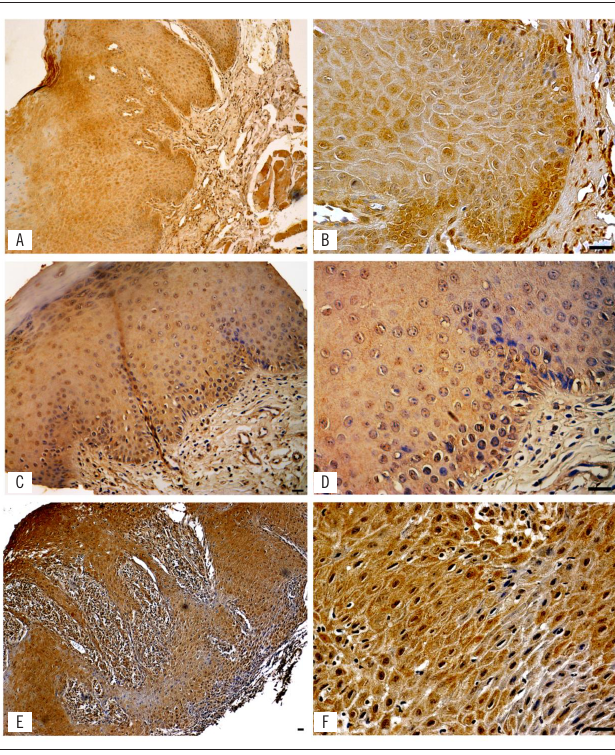
FIGURE 1 – Immunolabeling photomicrographs for TIMP-1 in leukoplakia Figura 1: Fotomicrografias de imunomarcação para TIMP-1 em Leucoplasias. (A) Leucoplasia leve com expressão da proteína no epitélio, conjuntivo, vasos e músculo A) mild leukoplakia with protein expression in connective epithelium, vessels, and skeletal estriado esquelético, (B) imunomarcação em todas as camadas do epitélio, sendo mais striated muscle; B) immunolabeling in all epithelial layers, more intense in the basal layer intensa na camada basal e na área de hiperplasia. (C e D) Leucoplasia moderada com and in the area of hyperplasia; C and D) moderate leukoplakia with TIMP-1 expression in expressão de TIMP-1 em todas as camadas do epitélio, sem variação da intensidade all epithelial layers, with no variation of intensity in each strata; E) severe leukoplakia with entre os estratos. (E) Leucoplasia severa com imunomarcação heterogênea, presente heterogeneous immunolabeling, present in all epithelial layers; F) stronger intensity in em todas as camadas epiteliais, (F) intensidade maior na camada espinhosa, com the spinous layer, with pleomorphic keratinocytes and variations between strong and weak queratinócitos pleomórficos e variação entre bem e pouco marcados. Barra de escala = labeling; scale bar = 20 µm. 20  m. TIMP-1: tissue inhibitor of metalloproteinase-1.